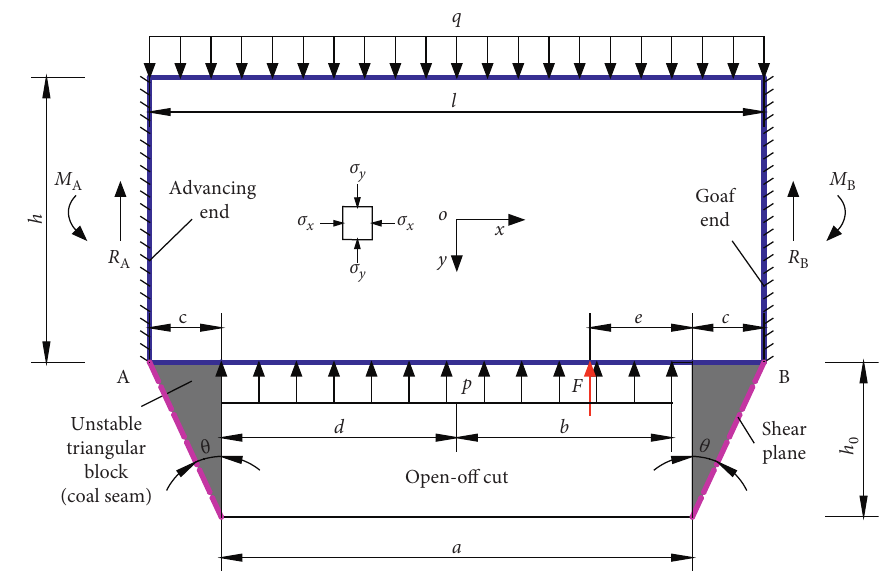
Figure 7: ARBBS model in open-off cut